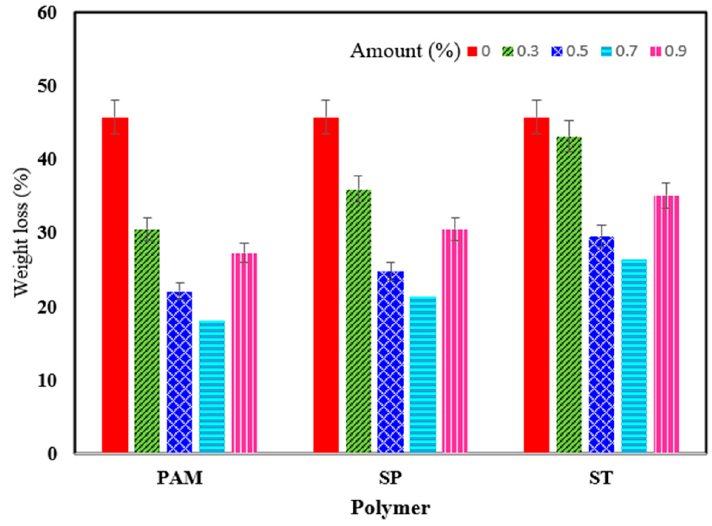
Figure 11. Weight loss of GGBFS geopolymers under sulfate acid attacks at 7 days.